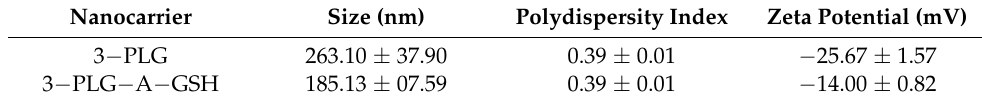
Table 1. The physico-chemical properties of nanocarriers. Values presented are means ±